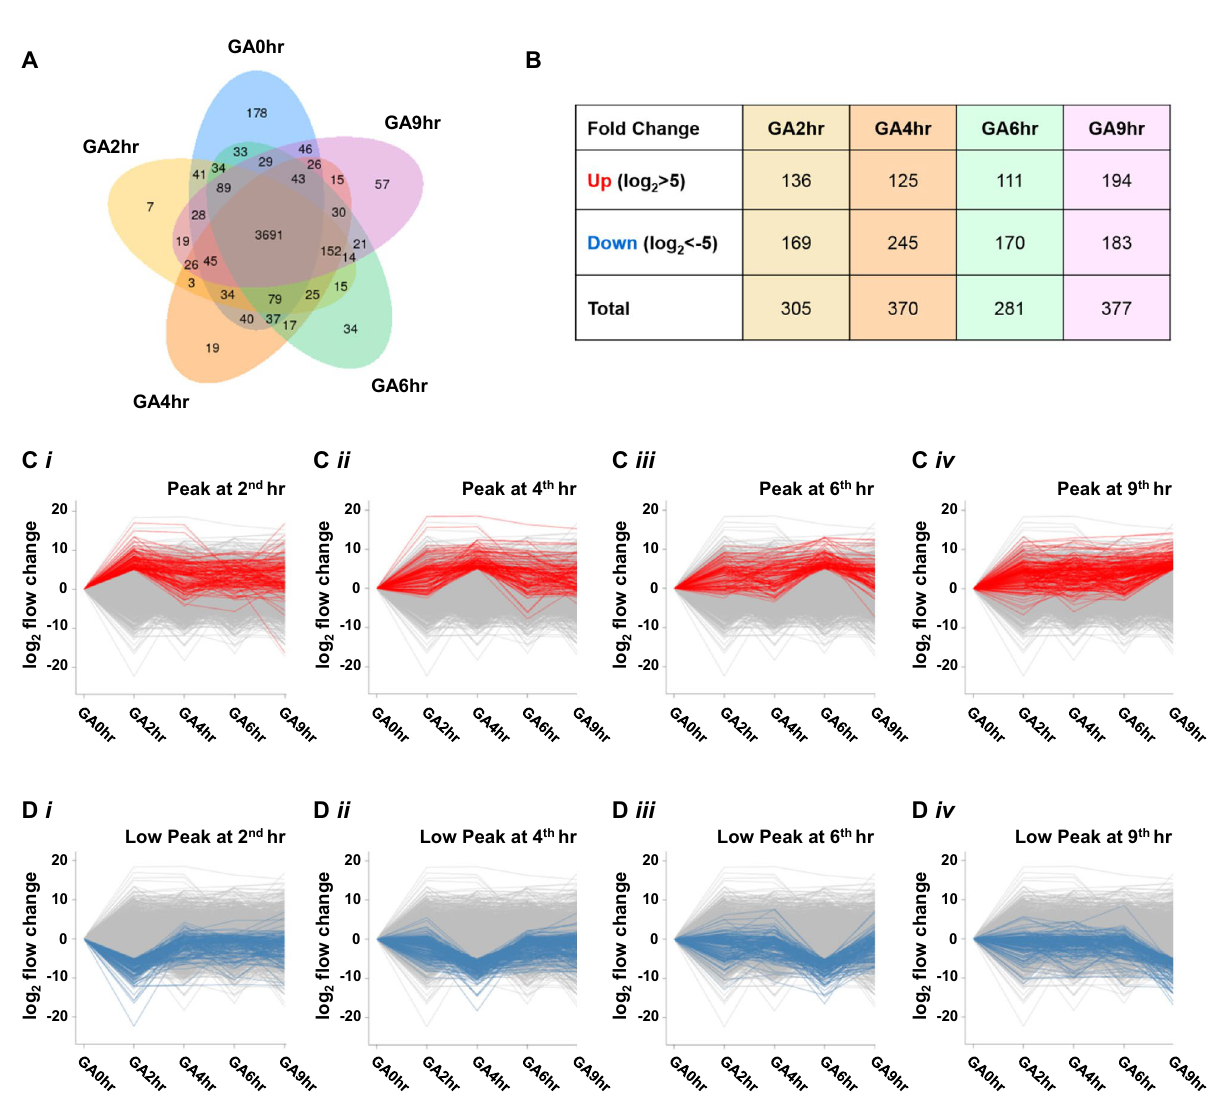
Figure 3. Change of gene expression profiles during gallic acid-induced cell death in HeLa cells. ( A ) Venn diagram reveals the number of common or unique genes that were differentially expressed (FPKM > 1) at five time points of the gallic acid-induced cell death process. ( B ) Number of up-regulated or down-regulated genes at the 2nd hour (GA2hr), 4th hour (GA4hr), 6th hour (GA6hr) and 9th hour (GA9hr) of the gallic acid-induced cell death process. ( C ) Up-regulation of gene expression during the gallic acid-induced cell death process. Log 2 fold change of gene expression at the ( i ) 2nd hour (GA2hr), ( ii ) 4th hour (GA4hr), ( iii ) 6th hour (GA6hr) and ( iv ) 9th hour (GA9hr) of the gallic acid-induced cell death process. The genes that display the highest expression (peak), together with log 2 fold change > 5, at the corresponding time point are highlighted in red. The log 2 signal values from three biological replicates were averaged for each time point, and normalized with the untreated cells (GA0hr). ( D ) Down-regulation of gene expression during the gallic acid-induced cell death process. Log 2 - fold change of gene expression at the ( i ) 2nd hour (GA2hr), ( ii ) 4th hour (GA4hr), ( iii ) 6th hour (GA6hr) and ( iv ) 9th hour (GA9hr) of the gallic acid-induced cell death process. The genes that display the lowest expression (low peak), together with log 2 fold change > 5 at the corresponding time point are highlighted in blue. The log 2 signal values from three biological replicates were averaged for each time point, and normalized with the untreated cells